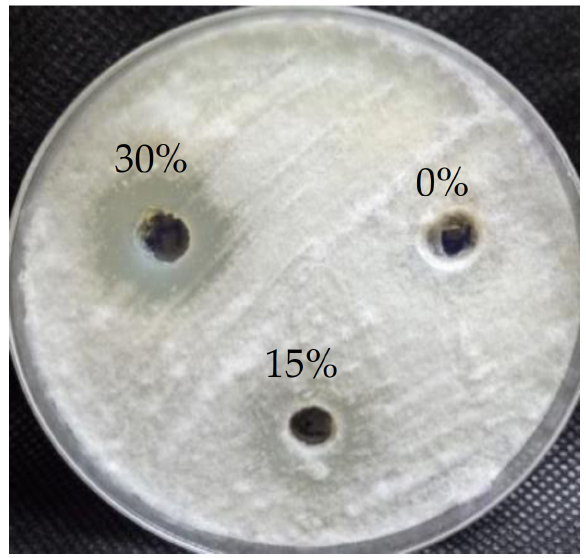
Figure 3. Inhibition zones caused by the crude extracts of A. ochraceus cultured at different levels of salinity (0, 15, and 30% seawater) against F. oxysporum